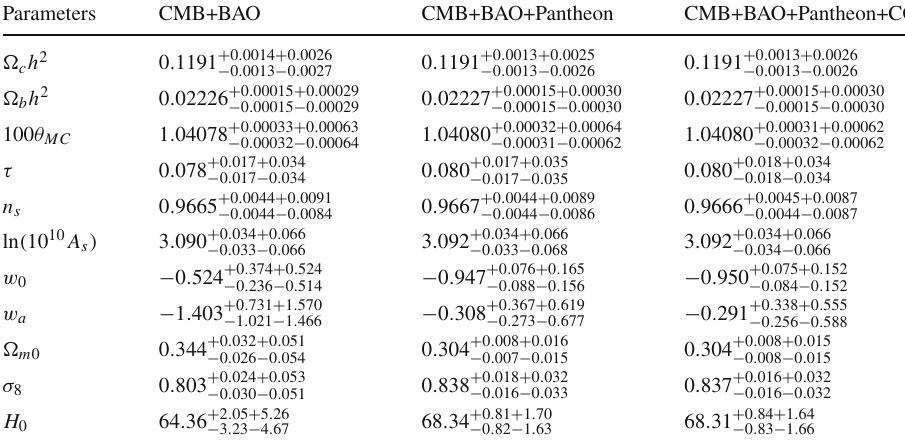
Table 3 Observational constraints on the dark energy parametrization, namely, the Ext1 of (7) using various observational datasets. We note that H 0 is in the units of km/Mpc/sec and (cid:12) m 0 is the present value of (cid:12) m = (cid:12) b + (cid:12)